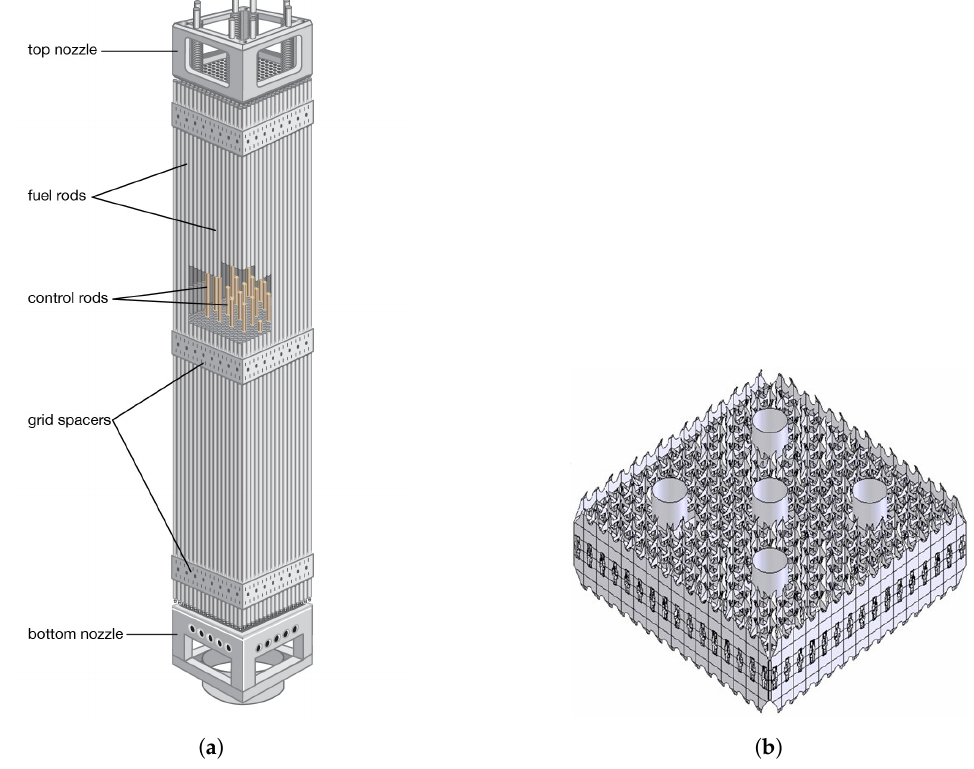
Figure 1. Pressurized water reactors (PWR) fuel assemblies design: fuel assembly ( a ) and spacer grid ( b